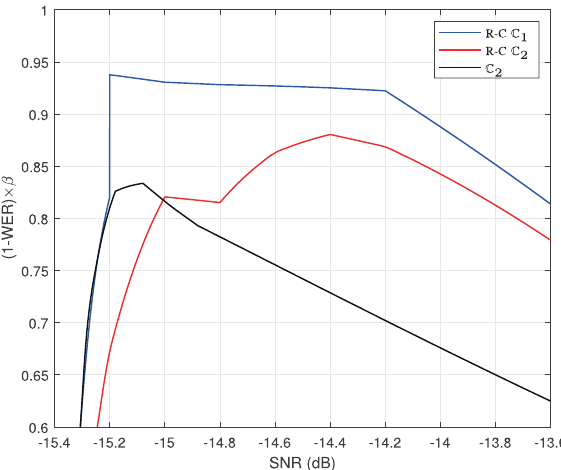
Fig. 4 Comparisons of effective ef fi ciency. We compare the effective ef fi ciencies, i.e., (1 − WER) × β of the IR schemes with three different error-correcting codes denoted by R-C C 1 , R-C C 2 , and C 2 in which R-C C 1 and R-C C 2 indicate the IR schemes with the rate- compatible MET-LDPC codes using C 1 and C 2 , respectively. Meanwhile, the IR scheme with the fi xed-rate MET-LDPC code of C C 2 is denoted by 2